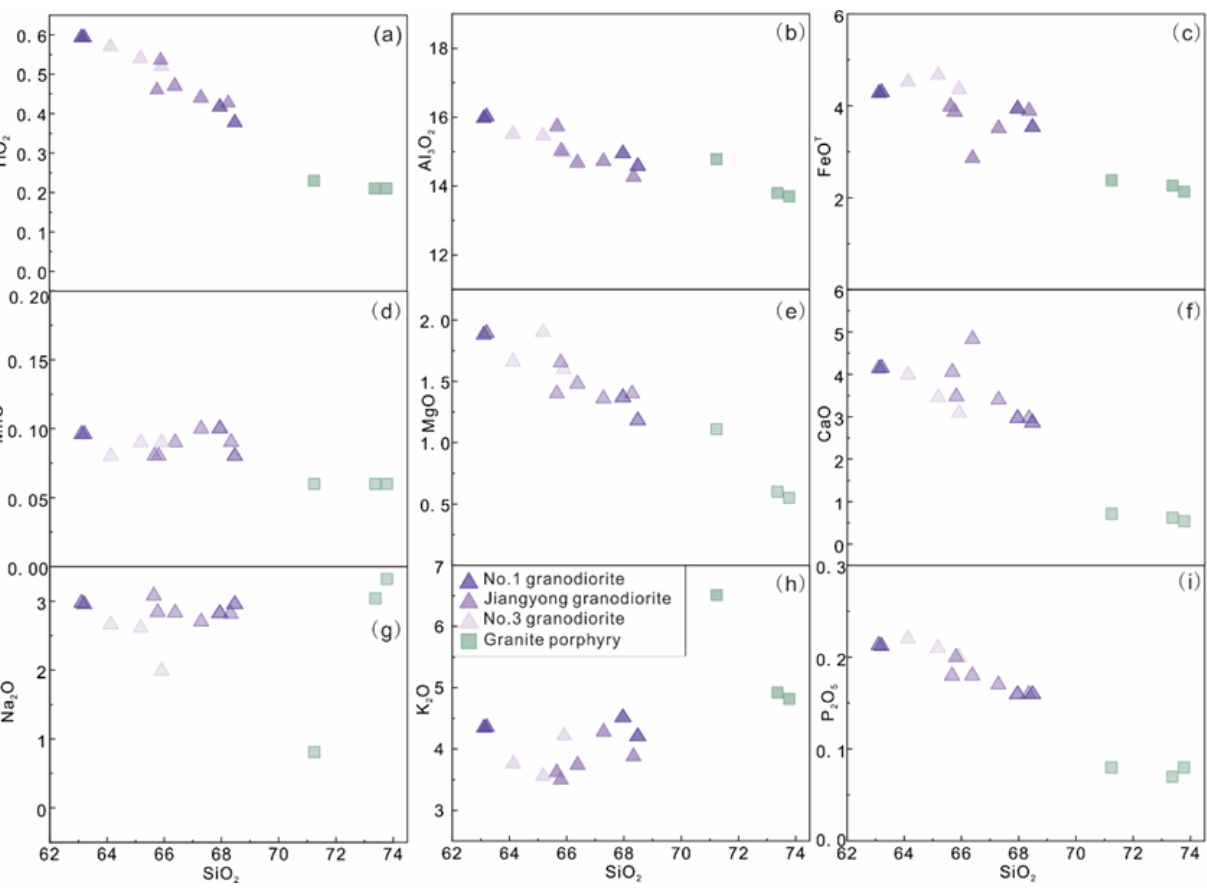
Figure 4. Harker plots for the Tongshanling granitoids: SiO 2 vs. ( a ) TiO 2 ; ( b ) Al 2 O 3 ; ( c ) FeO T ; ( d ) MnO; ( e ) MgO; ( f ) CaO; ( g ) Na 2 O; ( h ) K 2 O; ( i ) P 2 O 5 . ( d ) MnO; ( e ) MgO; ( f ) CaO; ( g ) Na 2 O; ( h ) K 2 O; ( i ) P 2 O 5